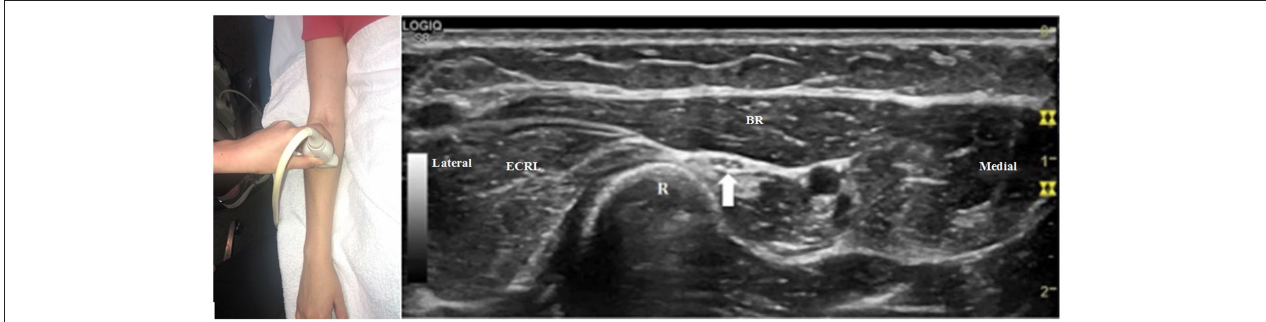
FIGURE 6 | The transducer is now more distal than in Figure 5 , and the superficial radial sensory nerve (arrow) is seen next to the convex, hyperechoic radius (R). BR, brachioradialis, ECRL, extensor carpi radialis longus.